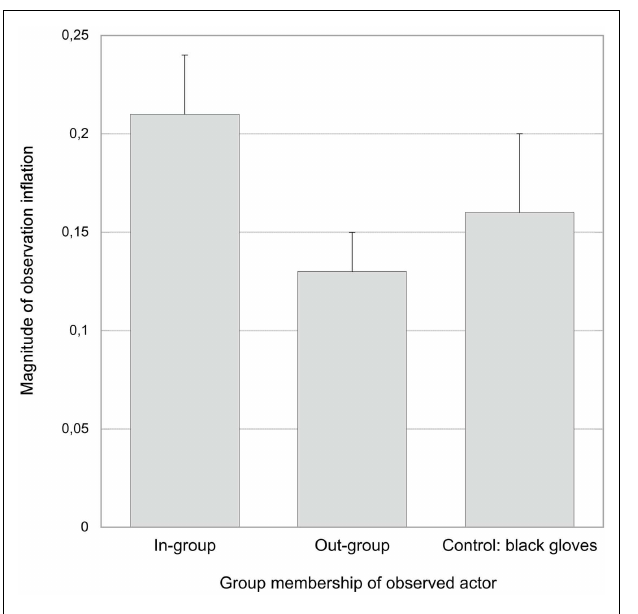
FIGURE 4 | Magnitude of the observation-inflation effect as a function of group membership of the observed actor. Error bars represent the standard error of